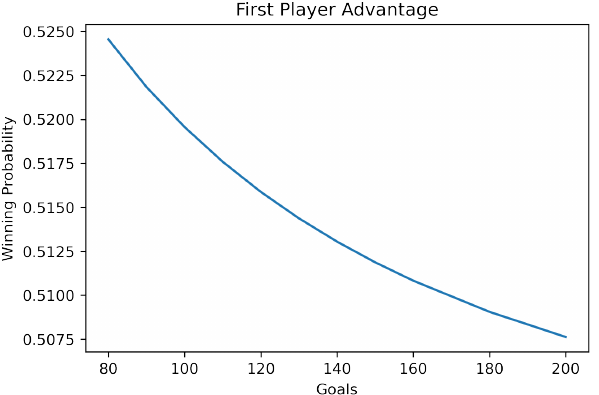
Figure 5. The winning probability of the first player when both players play